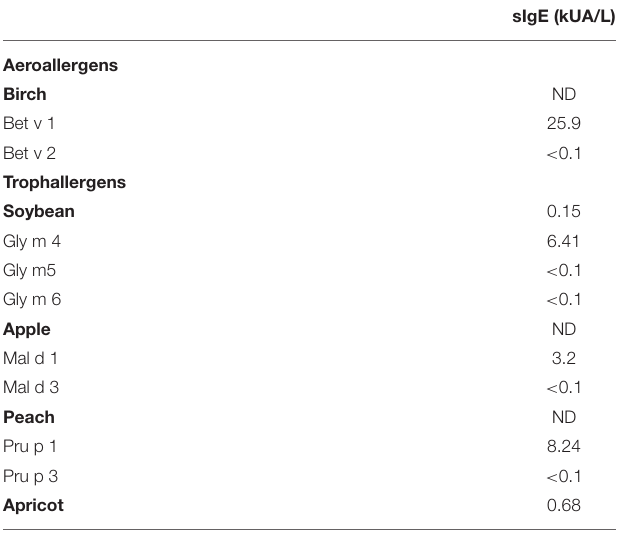
TABLE 1 | Results for serum specific IgEs tested.